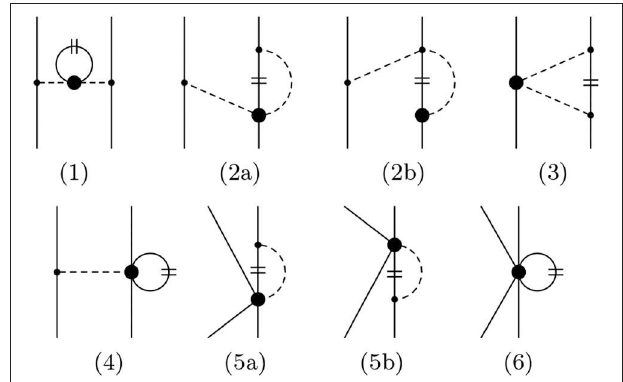
FIGURE 12 | Effective two-baryon interaction from genuine three-baryon forces. Contributions arise from two-pion exchange (1), (2a), (2b), (3), one-pion exchange (4), (5a), (5b), and the contact interaction